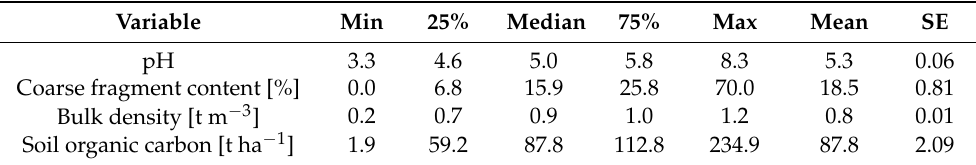
Table 2. Soil descriptors of the 324 sites. SE, standard error of the mean.